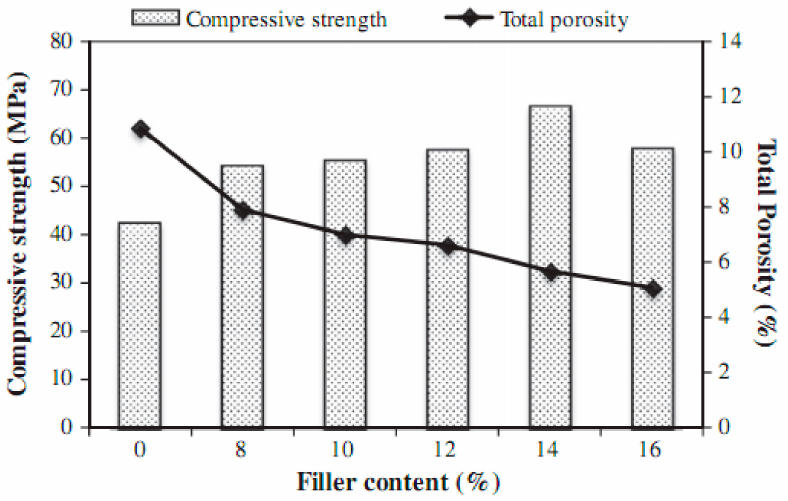
Figure 7. Water permeability test of concrete [109]. Reprinted with permission from Elsevier [109]. Water absorption (WA) is usually calculated using Equation